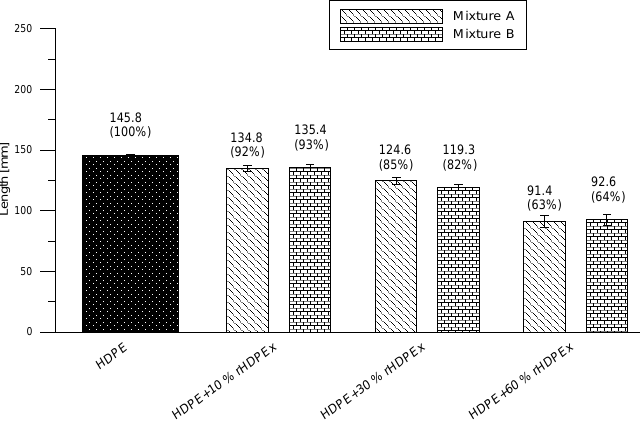
Figure 3. Polymer fluidity comparison—mixtures A,